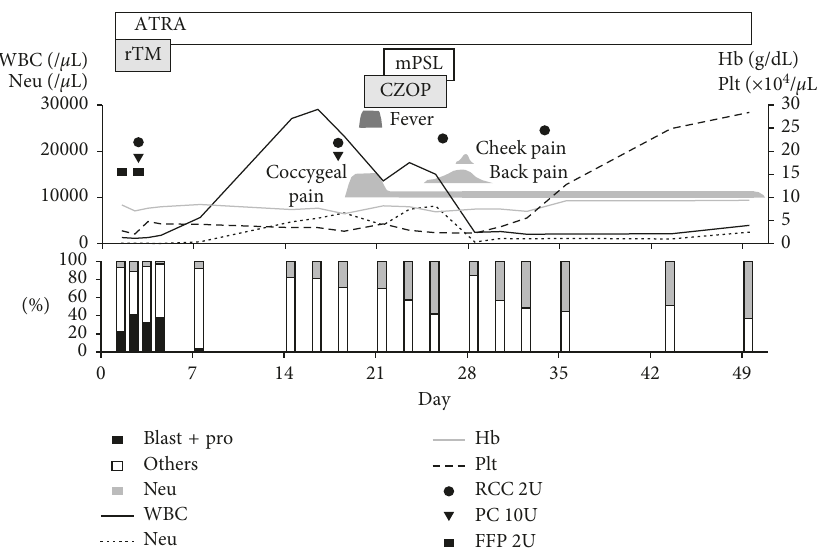
Figure 1: Clinical course of induction chemotherapy. On the horizontal axis, day 1 was set as the first day of induction chemotherapy. WBC, white blood cell; Neu, neutrophil; Hb, hemoglobin; Plt, platelet; Pro, promyelocyte; ATRA, all-trans retinoic acid; rTM, recombinant human thrombomodulin; mPSL, methylprednisolone; CZOP, cefozopran; RCC, red cell concentrate; PC, platelet concentrate; FFP, fresh frozen